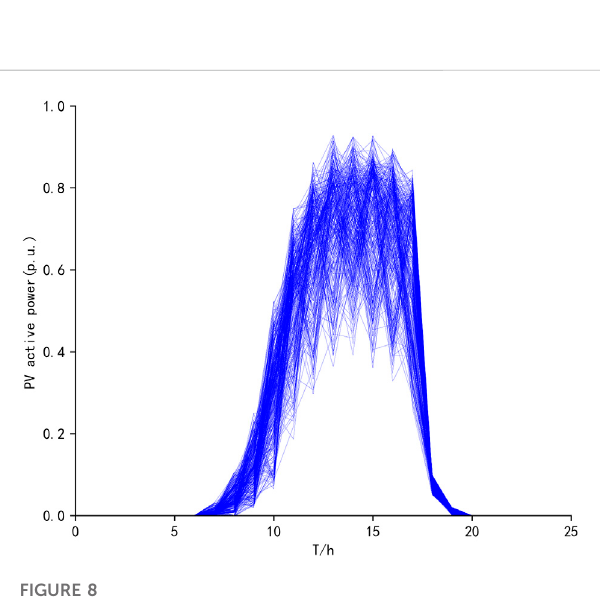
Scenarios of distributed PV power.